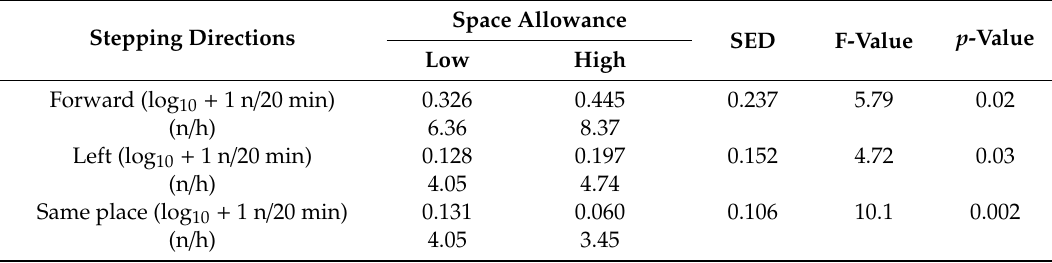
Table 2. Significant ( p < 0.05) e ff ects on sheep ( n = 6) stepping in di ff erent directions in the low and high space allowance treatments in simulated sea